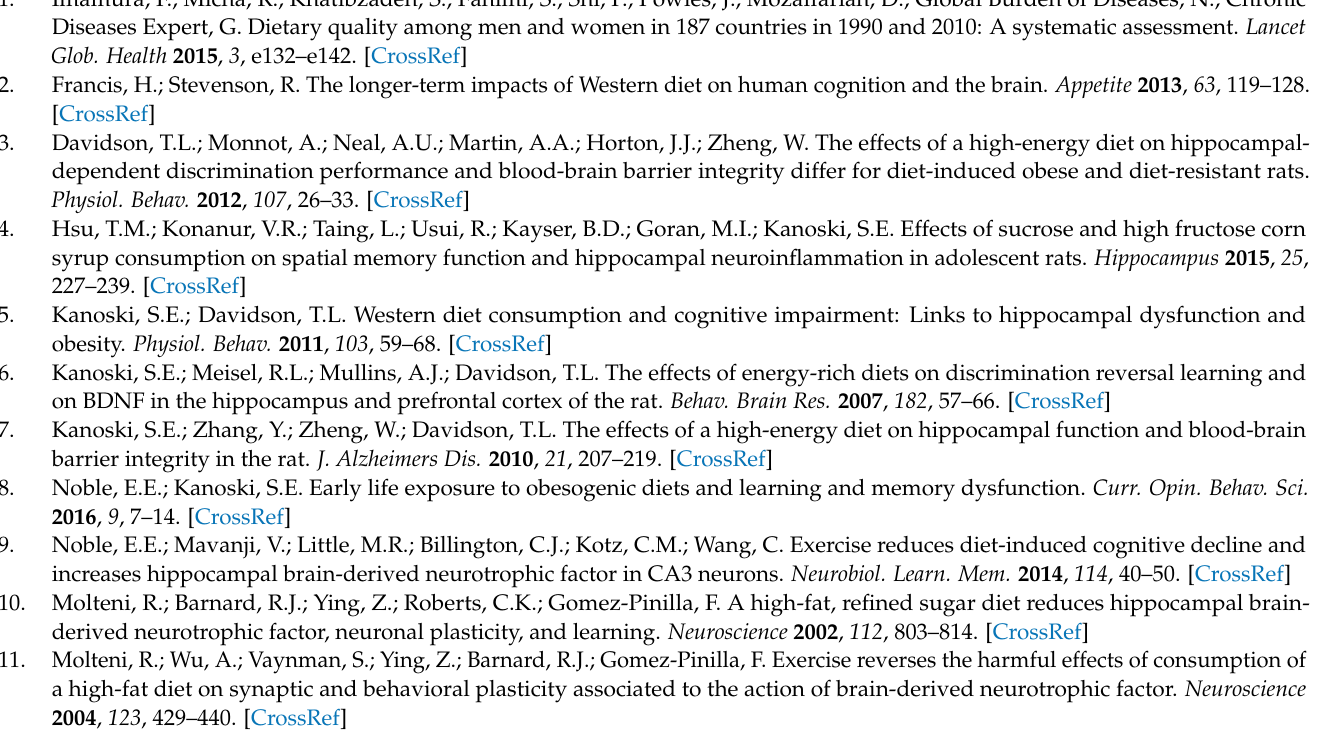
group; Figure S2: Body fat accumulation in female and male rats on control diet vs. Western diet; Figure S3: Average intake and macronutrient preferences of ovariectomized females on Western diet; Figure S4: Respiratory control in hippocampal mitochondria following consumption of a Western or control diet; Figure S5: Stain-free Western blotting in the hippocampus of rats fed either a Western or control